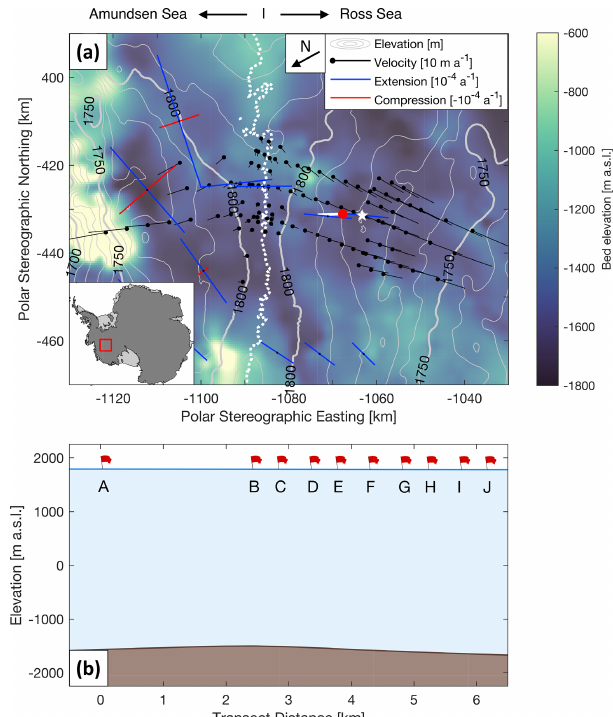
Figure 2. (a) Map of local surface (ma . s . l . with white contours at 10m intervals, REMA; Howat et al., 2019) and bed topog- raphy (background colour, MEaSUREs BedMachine Antarctica; Morlighem et al., 2020) in the WAIS Divide area, as well as GPS- measured surface velocities (black lines; Conway and Rasmussen, 2009) and strain configurations (blue and red arrows, Matsuoka et al., 2012). Strain rates below 2 . 5 × 10 − 5 a − 1 are not shown. The locations of the ApRES polarimetry transect (solid white line) and the results presented from Site I (red dot) in this study are ∼ 5km NE of the WAIS Divide ice core site (white star). The WAIS Divide is delineated as a thick dotted white line, with ice flowing north- wards towards the Amundsen Sea and southwards towards the Ross Sea. Location of (a) is shown as a red box in the map inset. (b) Sur- face and basal topography along the ApRES polarimetry transect showing the relative locations of the 10 ApRES measurement sites. Site A is closest to the WAIS Divide, and Site J is closest to the core site. The results shown in Figs. 4–6 depict the fabric profile of Site I, which has an estimated ice thickness of 3426m from